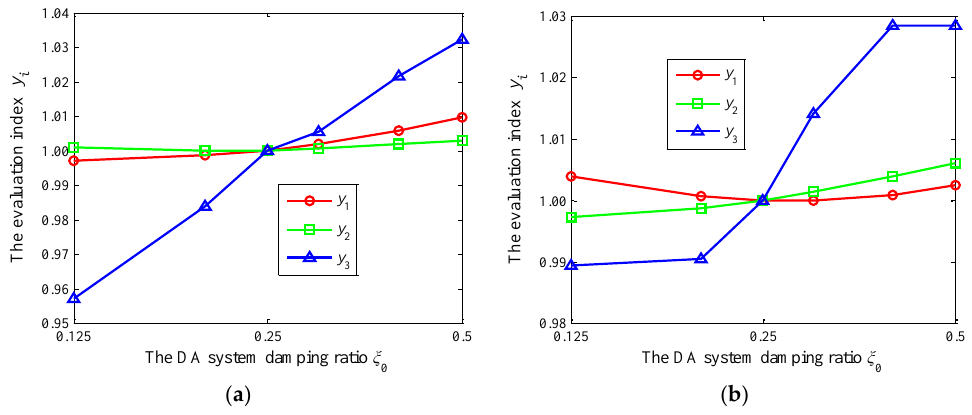
Figure 15. The evaluation index y i versus the DA system damping ratio ξ 0 for the wheelchair: ( a ) going up the step; ( b ) going down the step.